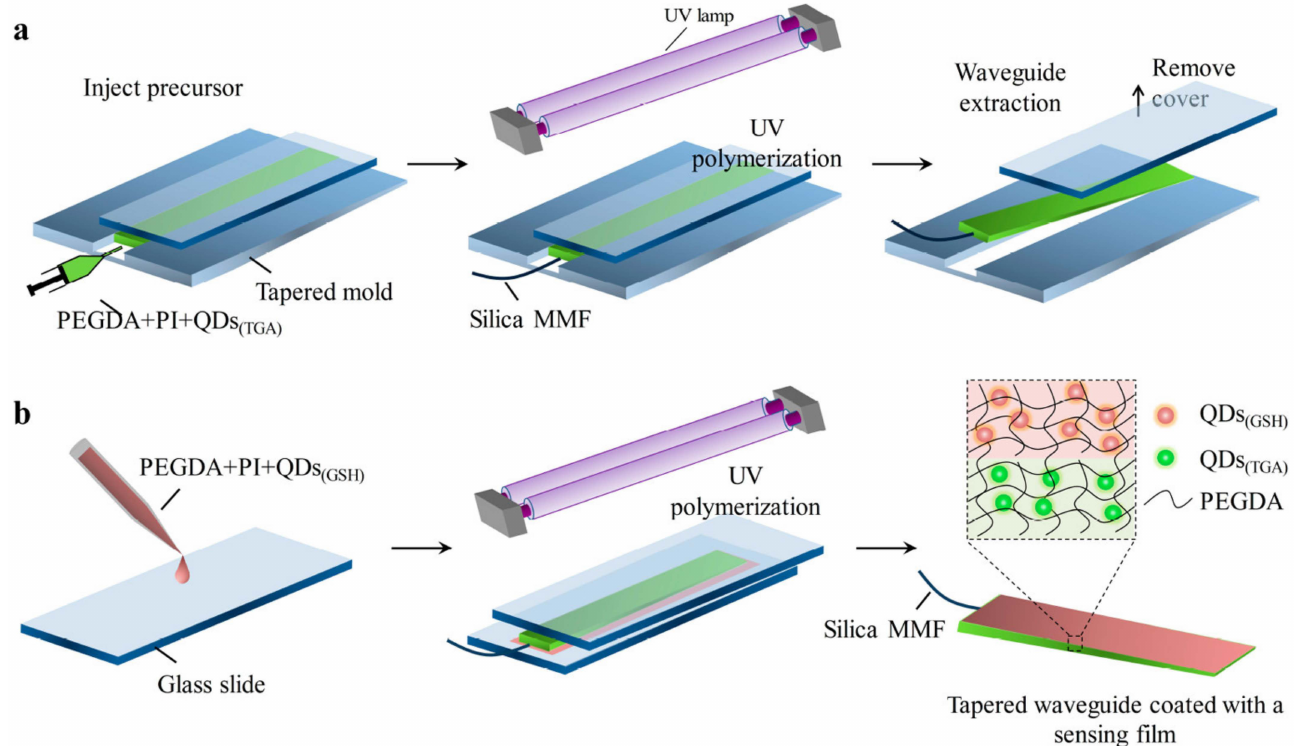
Figure 10. ( a ) Creating the tapered hydrogel waveguide through manufacturing. In situ photoinduced cross-linking of hydrogel precursor is performed in a tapered rectangular mold in order to create the waveguide taper. ( b ) Film coating. A thin film coating is formed through polymerization of a thin layer of hydrogel precursor on the waveguide surface, for which the waveguide taper is clamped between two microscopic glass slides to achieve a uniform thickness. Reproduced with permission from ref. [119] © 2023 American Chemical